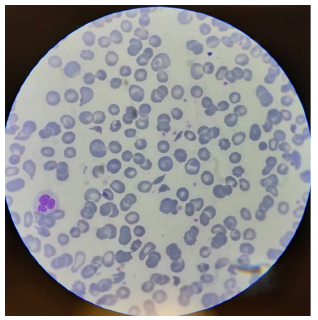
Figure 1. Chest computed tomography (CT); diffuse hyper-aeration of both lungs with interstitial infiltrations in the right middle, right upper, and right lower lobes as well as inter-lobar fissural nodular lesions.